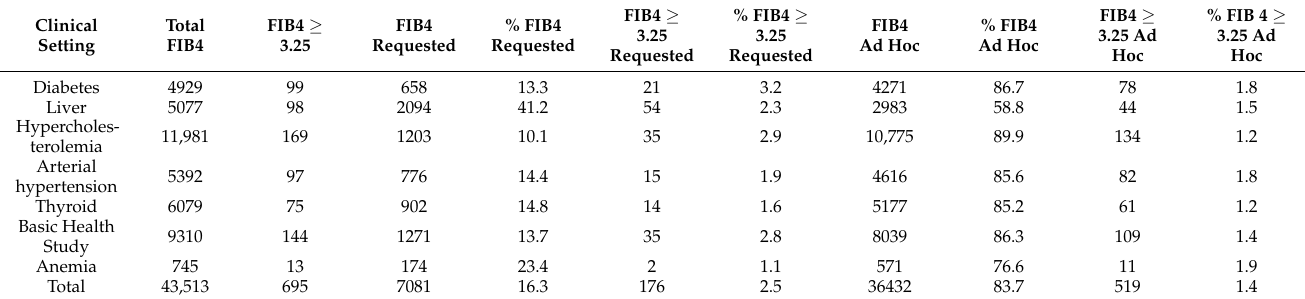
Table 2. Summary of data of FIB4 requested and added according to the clinical setting.